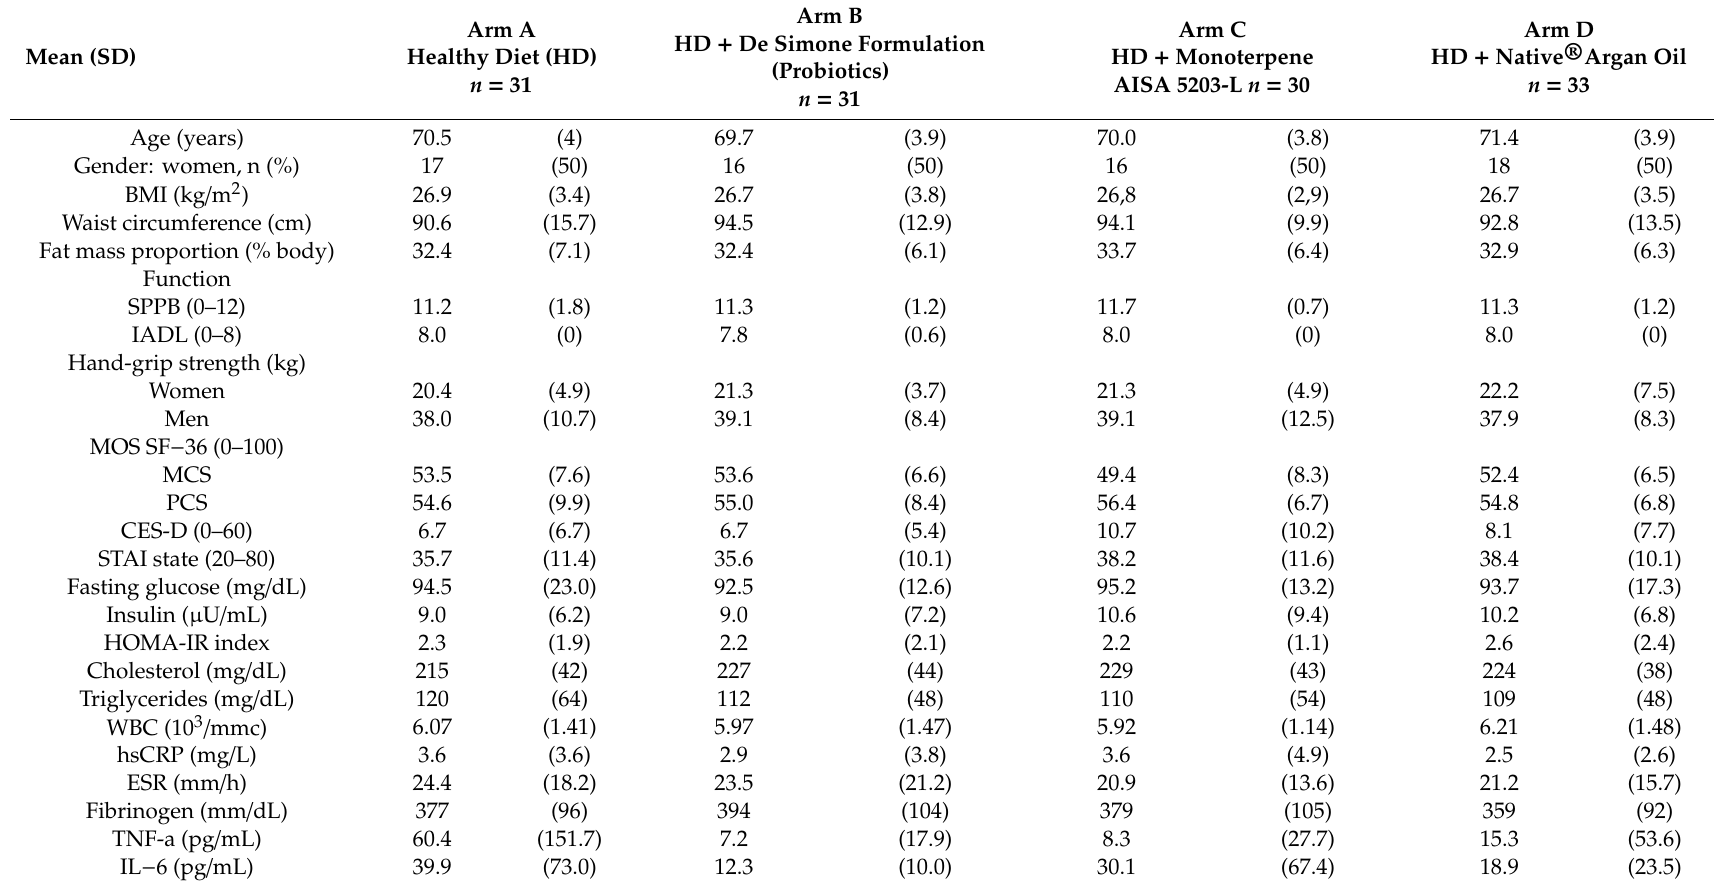
Table 1. Participants’ baseline characteristics according to their allocation